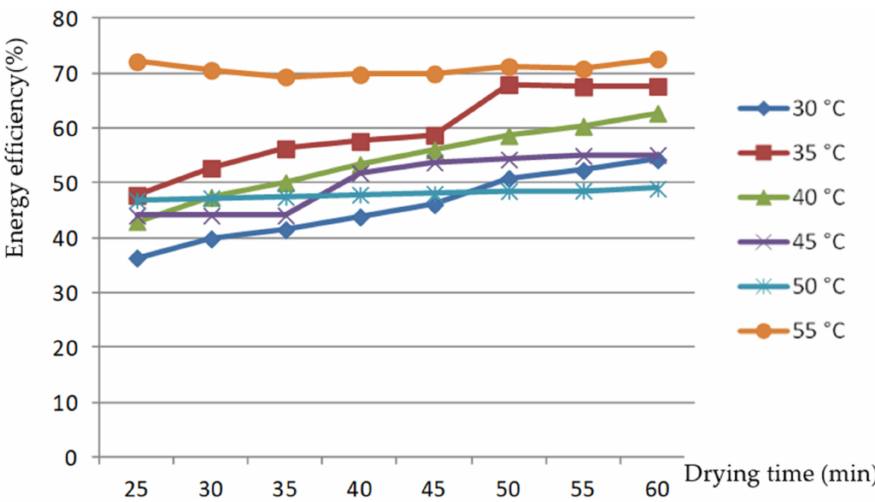
Figure 4. Changes in energy efficiency with drying time at different air temperatures.